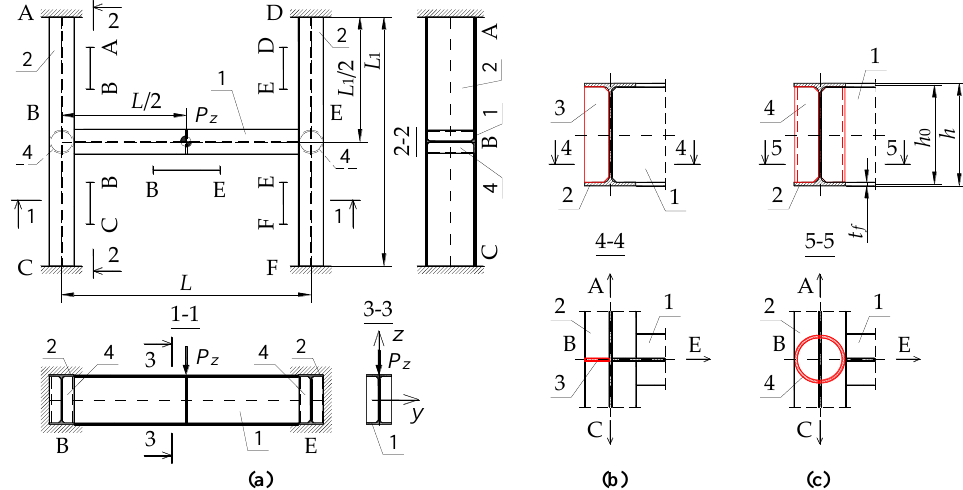
Figure 1. Diagram of the grillage: ( a ) view from the top, ( b ) flat stiffener ( t p = 8 mm), ( c ) closed- section stiffener (Ø139.7/8). Notation: 1 — main (coupling) beam, 2 — support beam, 3 — flat stiffener, 4 — closed-section stiffener [33].